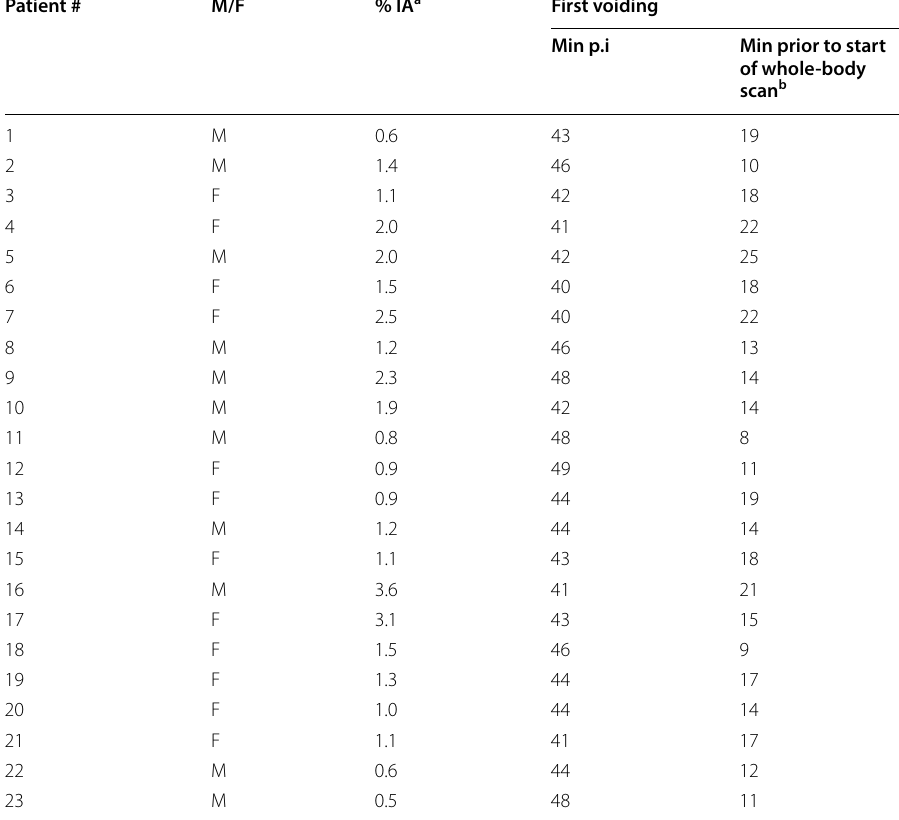
Table 2 Collected urinary bladder